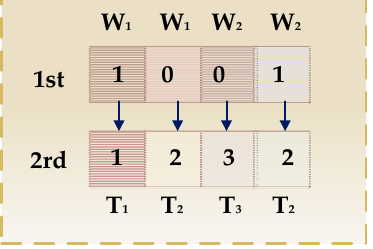
Figure 5. Upper-level algorithm coding schematic.